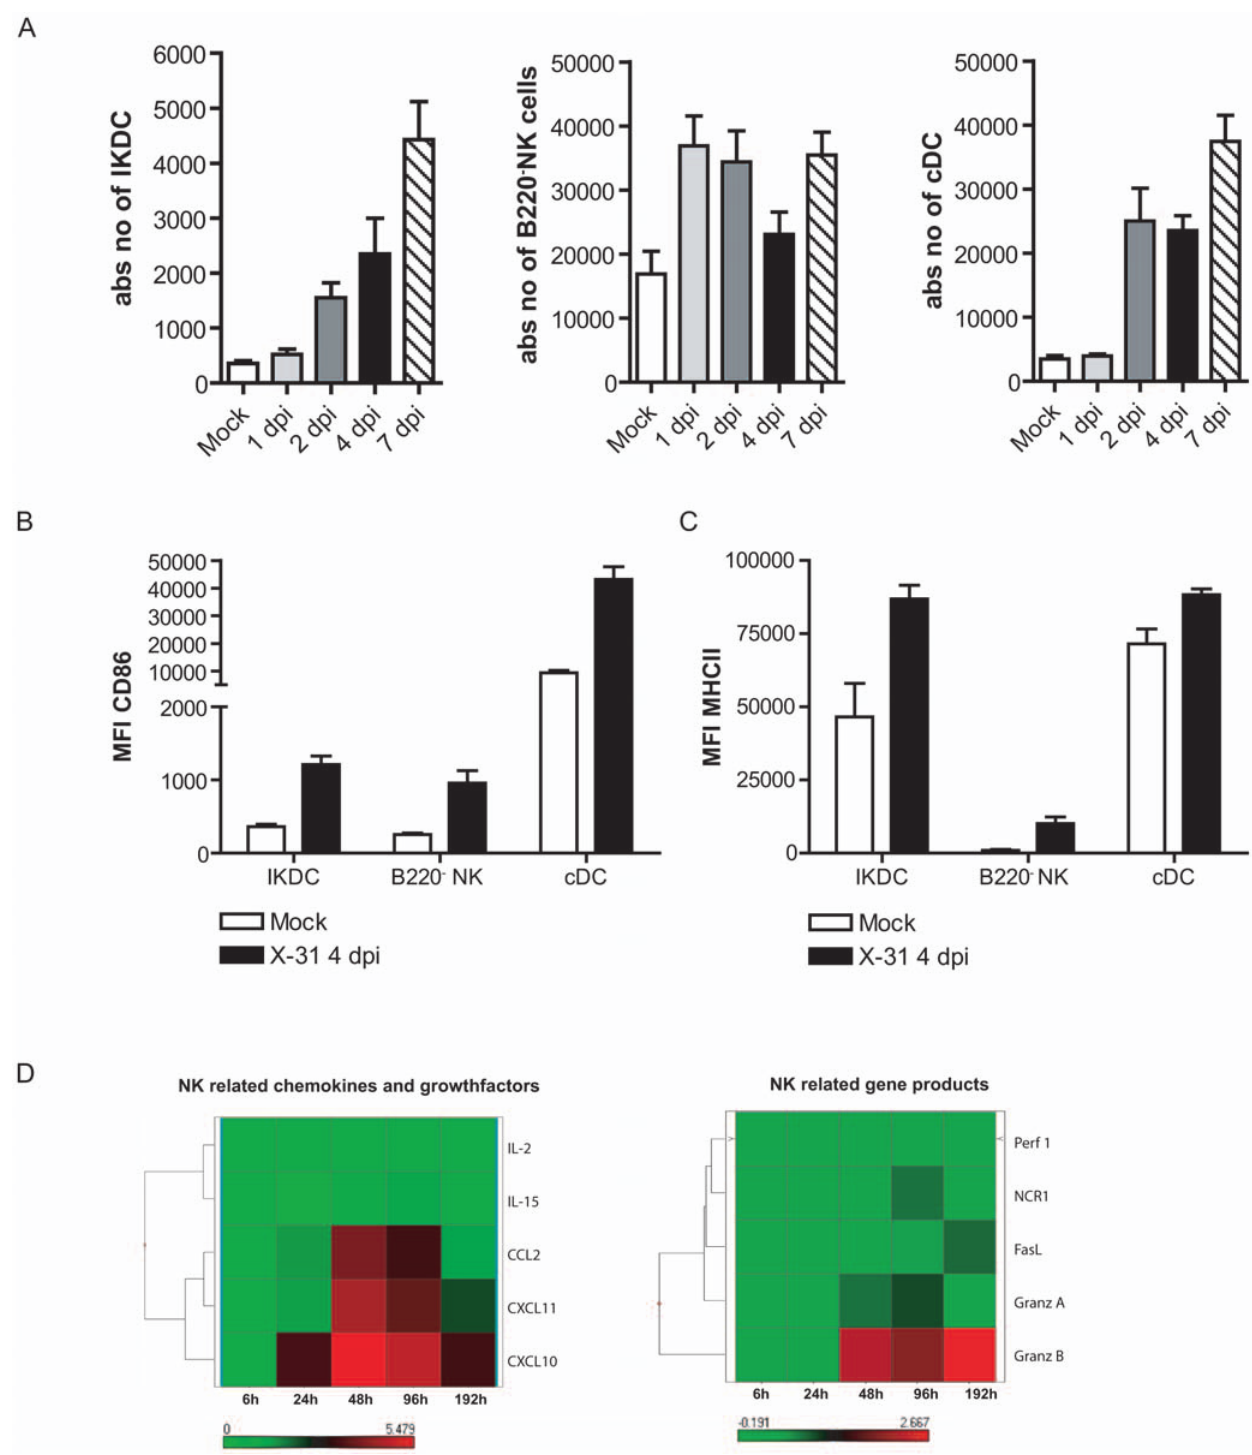
Figure 3. Kinetics of increase in IKDCs, B220 2 NK cells, and cDCs in lung tissue after influenza virus infection. (A) Cell populations were gated as demonstrated in Figure 1. Histograms demonstrate absolute numbers of IKDCs, B220 2 NK cells and cDCs at different time points after infection. Bars represent mean values + / 2 SEM of at least 5 mice per group. CD86 (B) and MHCII (C) expression on cell populations at 4 dpi expressed as mean MFI + / 2 SEM, derived from at least five mice per group. Similar results were obtained from three separate experiments (D) Gene expression analysis using Aff ymetrix GeneChips. Top heat map shows NK related chemokines and growth factors. Lower map shows NK related gene products.